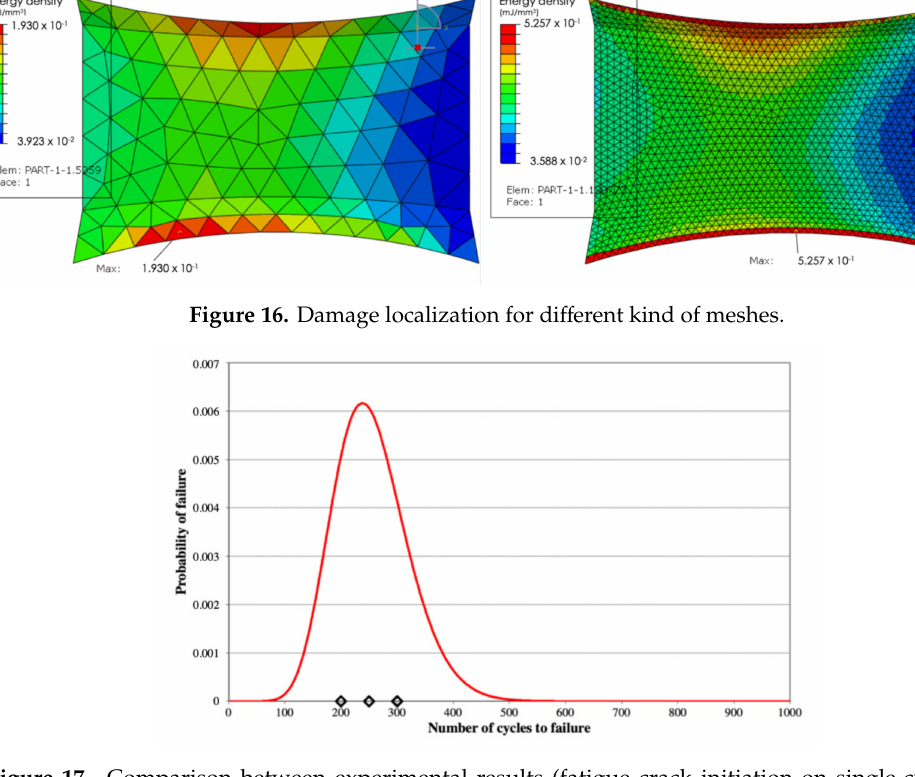
Figure 17. Comparison between experimental results (fatigue crack initiation on single-cylinder specimens represented by diamonds) and the foreseen scattering for fatigue